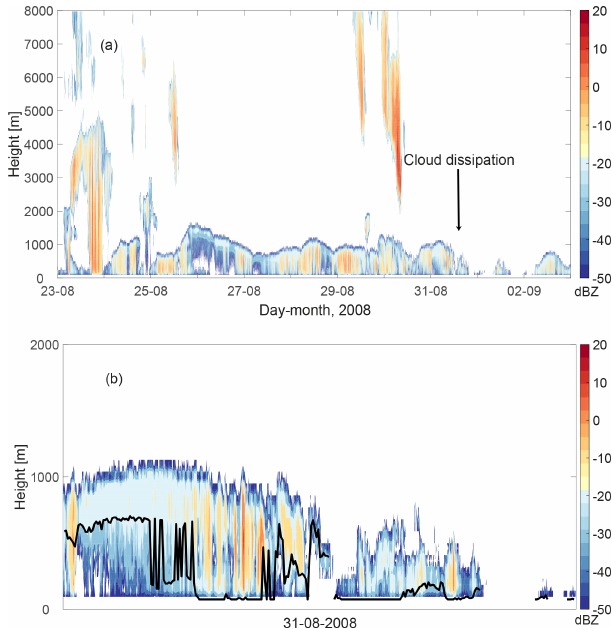
Figure 1. Radar reflectivity factor (colors, dBZ) contour time series for the period 23 August to 2 September 2008 (a) and for 31 August 2008 (b) . The ceilometer measurements of the cloud base height are shown with the black solid line in (b)